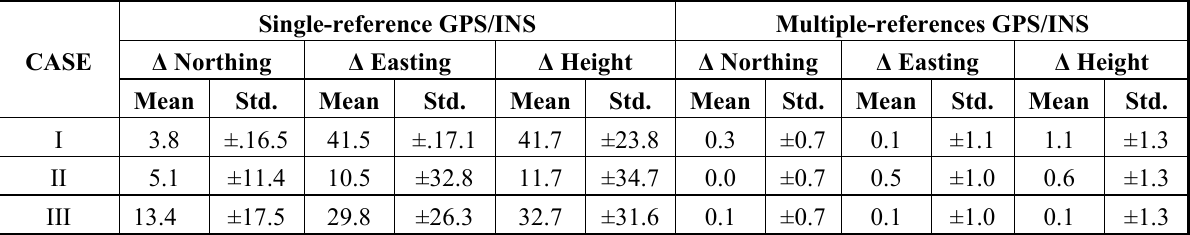
Table 2. Statistical summary of the coordinate differences between the references and estimates (unit: centimetres).